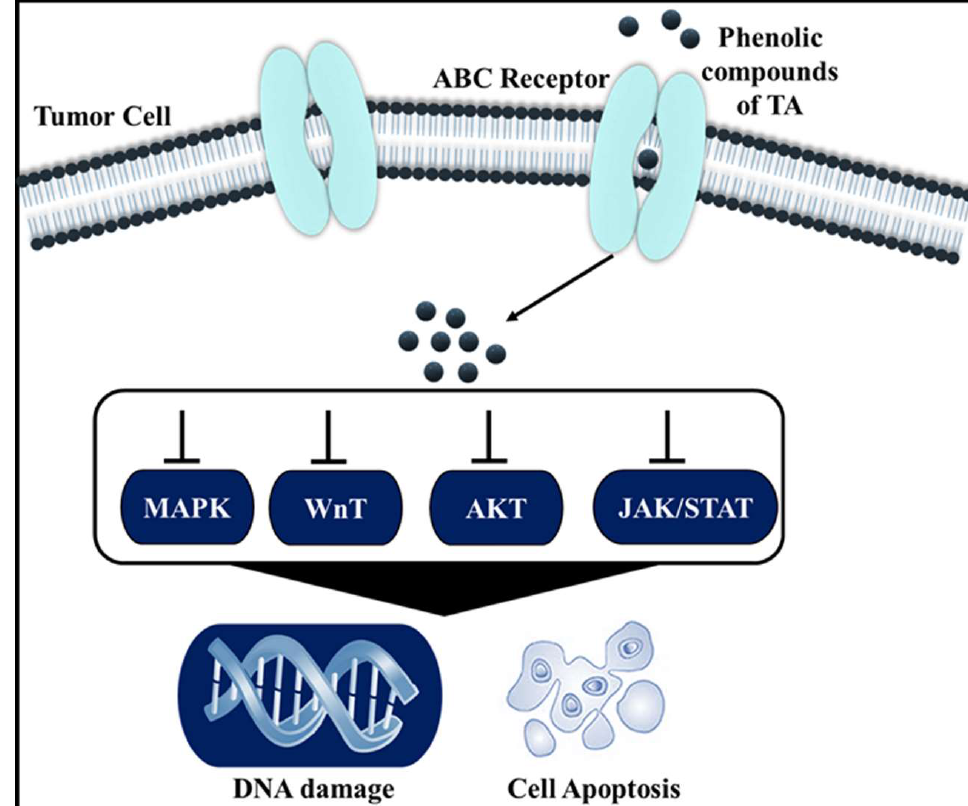
Figure 6. Schematic representation of the mechanisms behind the anticancer activity of TA extracts.